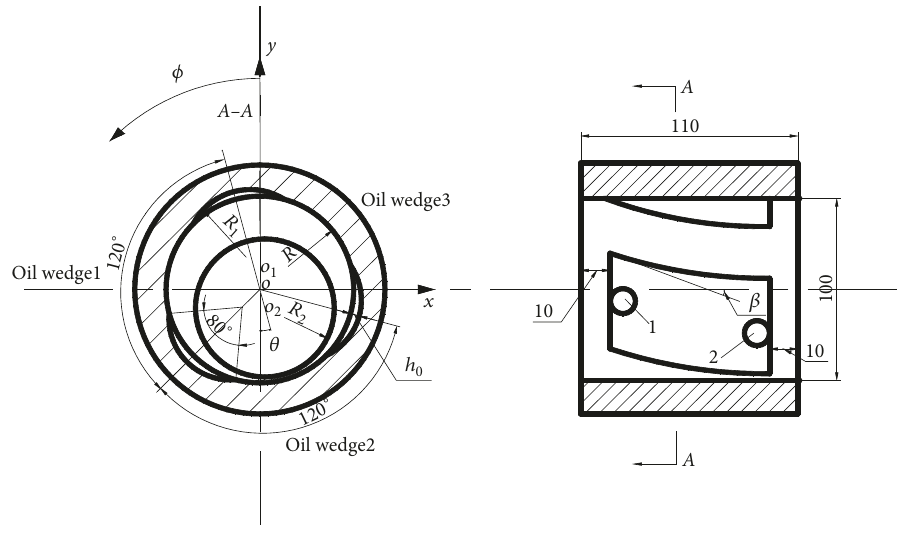
Figure 1: The structural diagram of spiral oil wedge sleeve